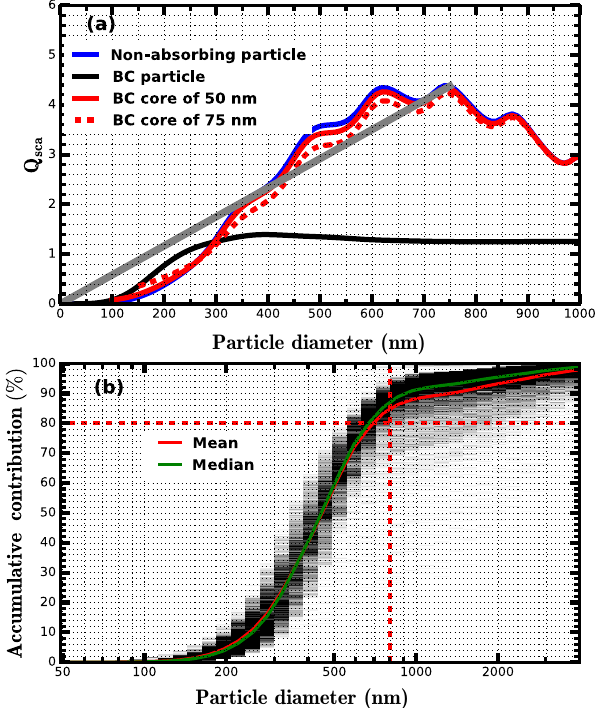
Figure 2. (a) Q sca at 550nm as a function of particle diameter for four types of aerosol particles: almost non-absorbing aerosol parti- cle, BC particle, BC particle core–shell mixed with non-absorbing components and the radius of inner BC core are 50 and 70nm. The grey line corresponds to the fitted linear line for the case of non-absorbing particle, when particle diameter is less than 750nm. (b) Simulated size-resolved accumulative contribution to σ sp at 550nm for all PNSDs measured during the Wangdu campaign, the colour scales (from light grey to black) represent occurrences. The dashed dotted lines in panel (b) represent the position of 800nm and 80% contribution,